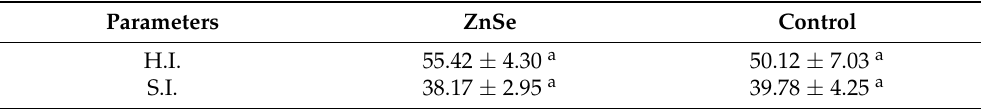
Table 4. Homogeneity (H.I.) and selection (S.I.) indices of total mixed ratio (TMR) distributed to the two experimental groups. Data are expressed as Lsmeans ± SE. a Same letters indicate no significant